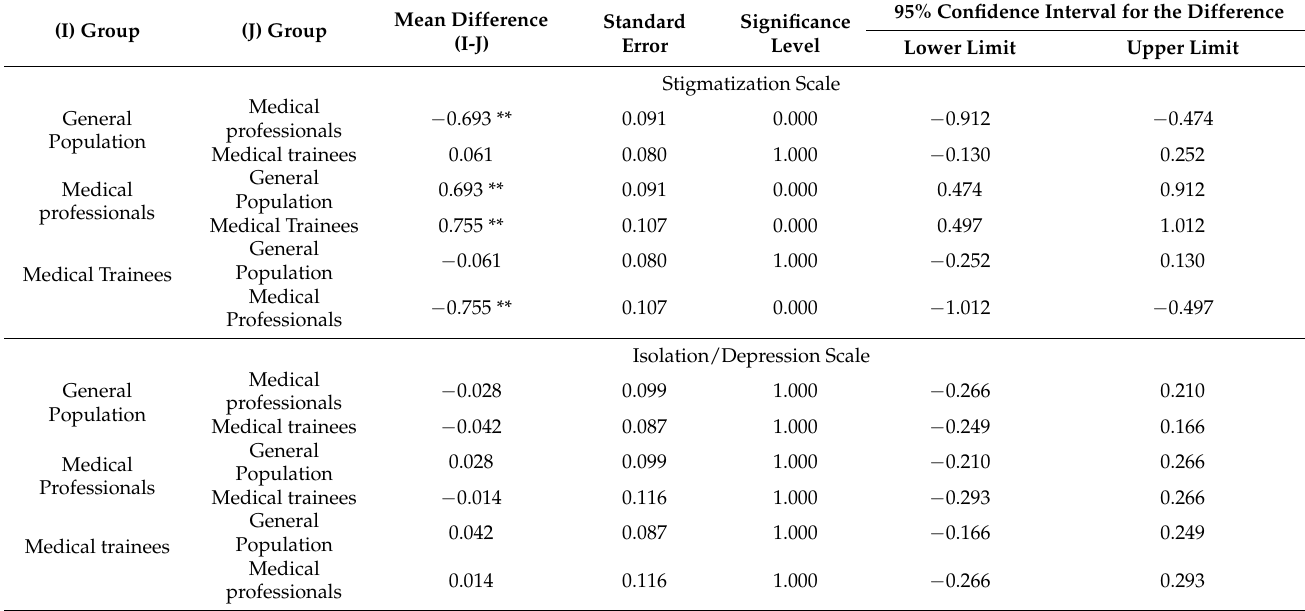
Table 2. Results of the pairwise comparisons according to Bonferroni of the three study groups post hoc of the MANCOVA regarding the sum scores in the “stigmatization scale” and “isolation/depression scale” of the SOSS. (I)